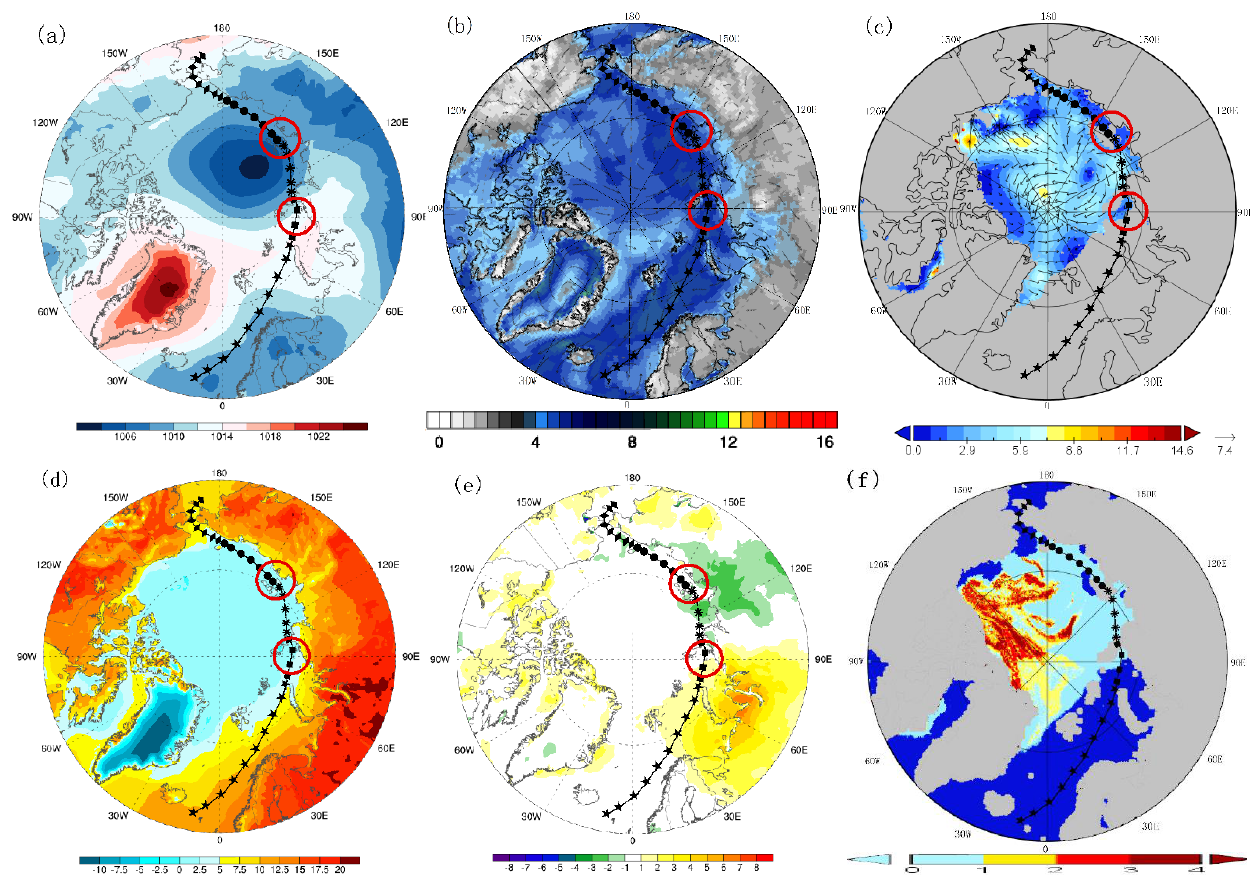
Figure 13. Distribution map of ( a ) sea level pressure (unit: hpa); ( b ) wind field (unit: m −1 ); ( c ) sea ice movement (unit: m −1 ); ( d ) temperature (unit: centigrades); ( e ) temperature anomaly (unit: centigrades) and ( f ) sea ice age (unit: year) in the Arctic summer in July 2016. (The red circles represent the special areas.)